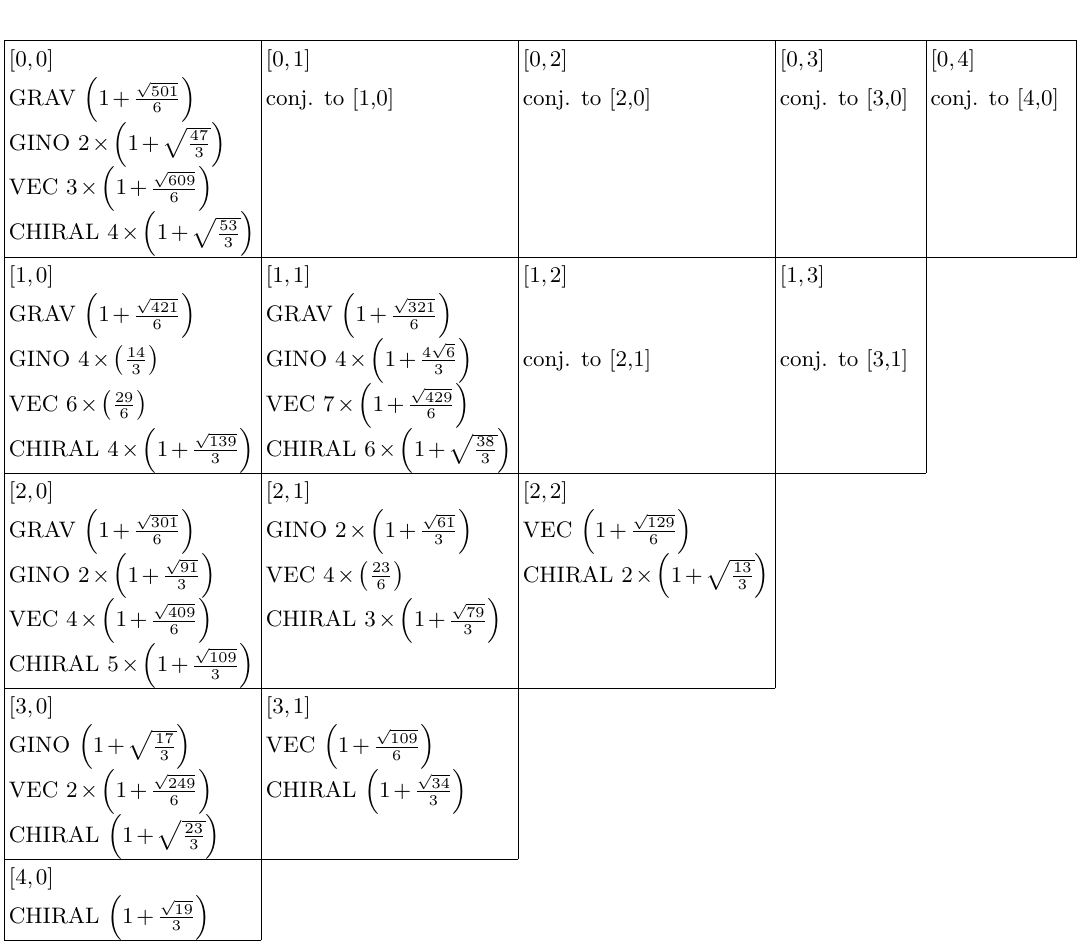
Table 14 . Supermultiplets at KK level n = 2 for the N = 1 SU(3)-invariant AdS 4 solution of type